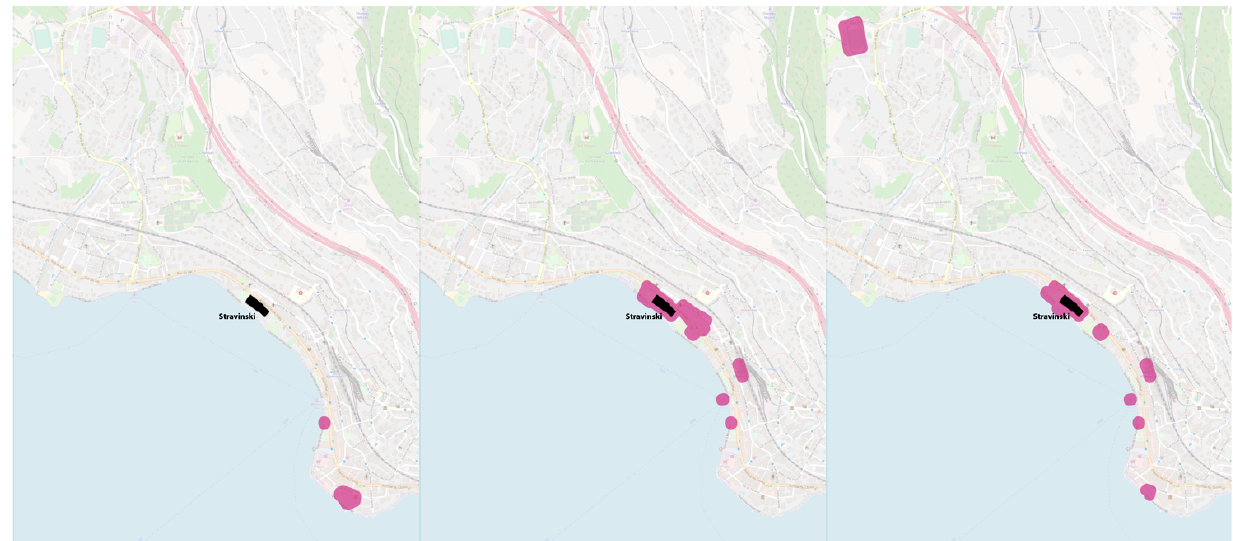
Figure 7. Analysis of the evolution of areas affected by the Festival (territorial grip). Note: From left to right: 1990, 2000, and